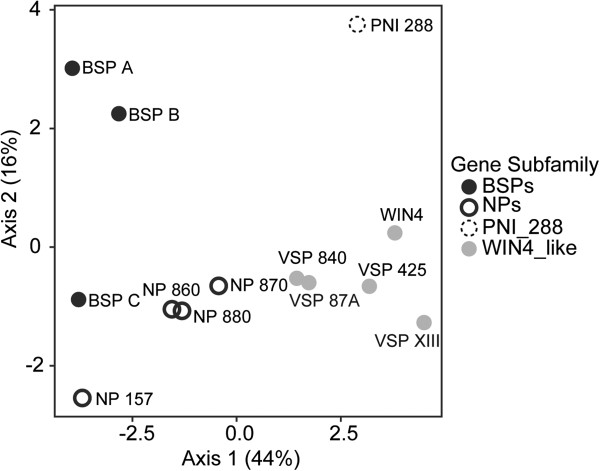
Principal component analysis (PCA) of NP-like gene expression in Populus trichocarpa. PCA illustrating the relationships of NP-like genes in Populus trichocarpa based upon the expression data presented in Figure 1B. The percentage of variation explained by each axis is given in parentheses next along each axis.